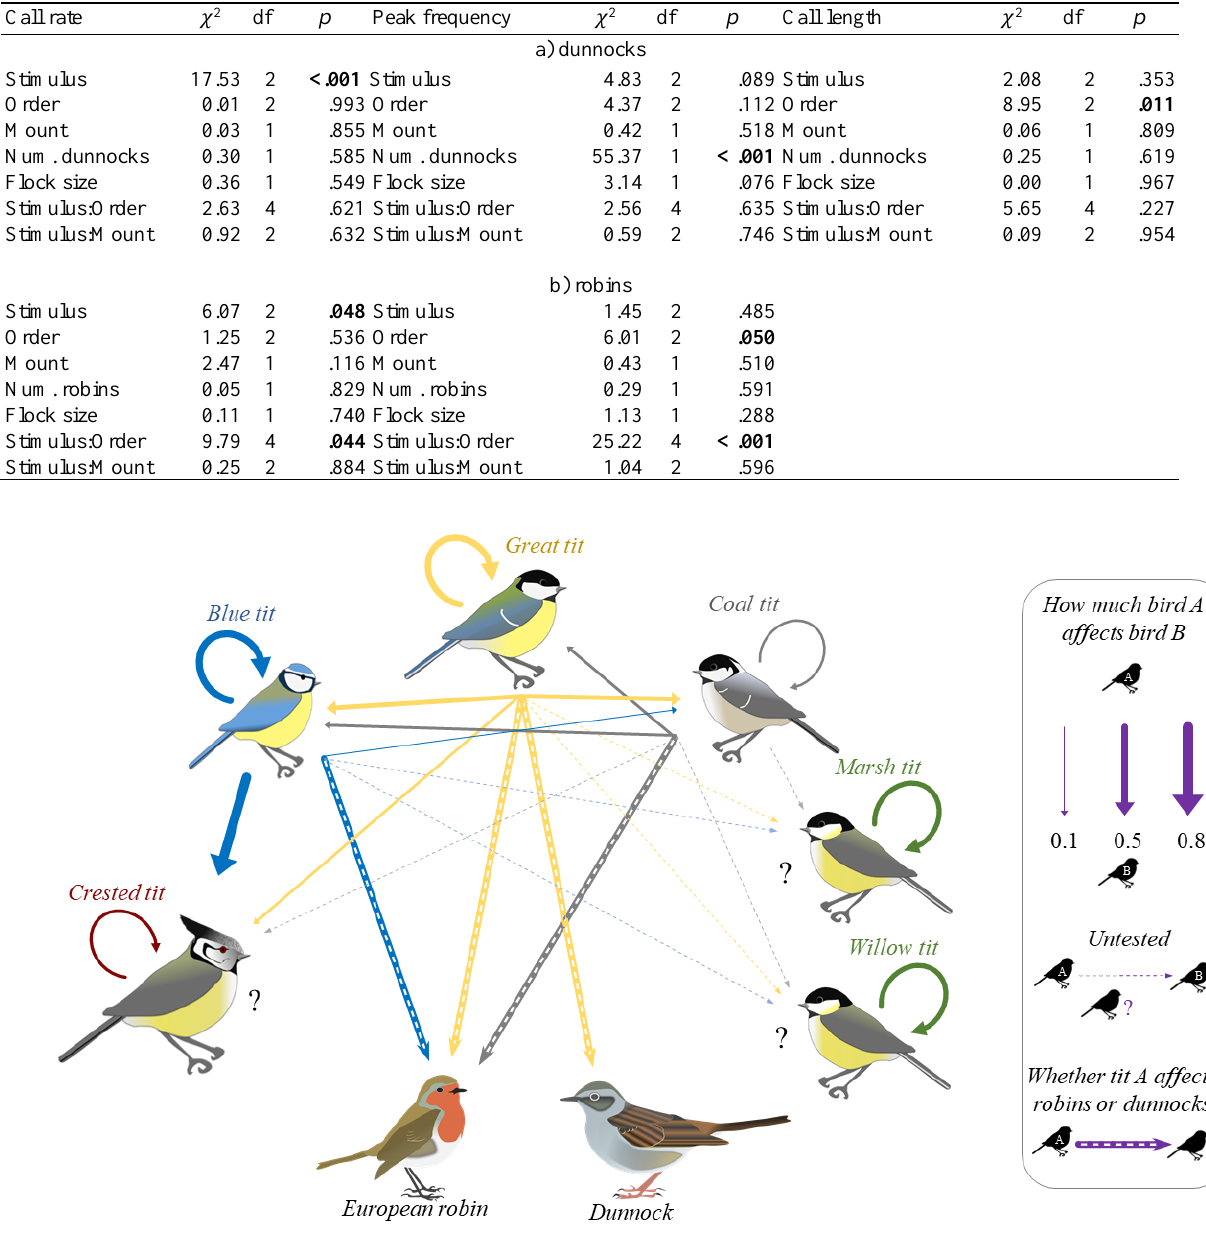
Figure 2 . A representation of the influence different species have on conspecific and heterospecific calling behavior. Arrows represent the relative strength of effect on recipient’s calling behavior (encoding strategies influenced by a species/total encoding strategies – tits) or whether they ‘avoid’ calling when another species calls – dunnocks and robins), arrow direction indicates influence of one species on another, small dashed lines/question marks indicate untested effects of other birds on focal bird (dashed lines) or effects of focal bird on other birds (question mark), and no lines show a lack of an effect (robins and dunnocks were tested only for effects on each other’s calling behavior, and whether they were affected by blue, great, and coal tits). Arrow color indicates which bird is affecting